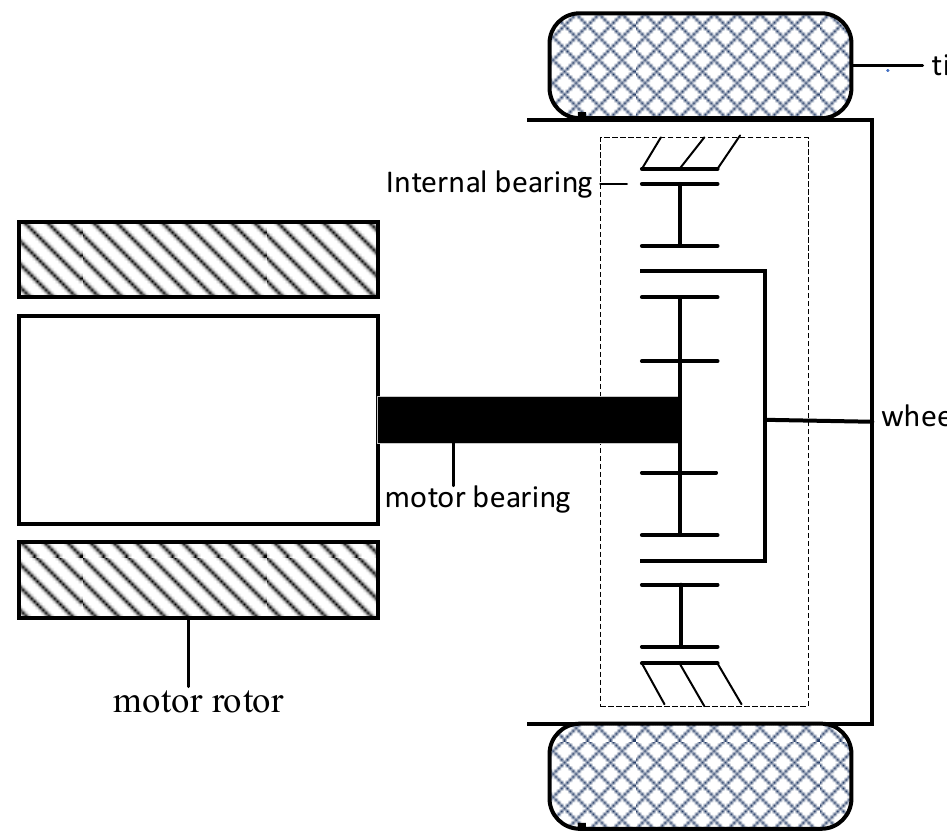
Figure 1. Structure characteristic diagram of wheel side drive.